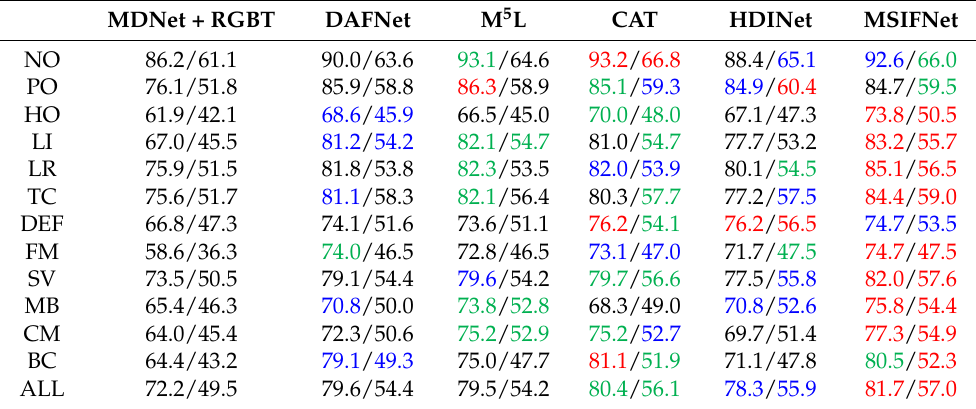
Table 2. A tt ribute-based PR/SR scores (%) on the RGBT234 dataset. Table 2. Attribute-based PR/SR scores (%) on the RGBT234 dataset.